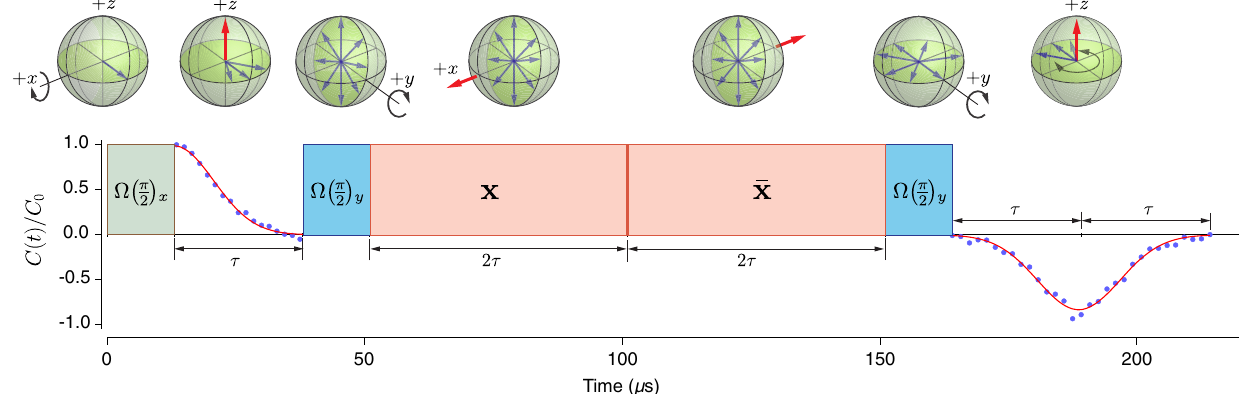
FIG. 3. Pulse diagram and data (blue circles) for the magic-echo pulse sequence performed using τ ¼ 25 μ s and substituting 13- μ s- long OCT-AHT π /2 pulses in place of hard-pulse rotations. The correlation measurements are performed after applying an Ω ð π /2 Þ ¯ x pulse (not shown) at the times corresponding to the data points. The Bloch sphere diagrams above show the spin orientations (blue arrows) during the magic-echo sequence. The red arrows point in the direction of the external magnetic field during free evolution periods and in the direction of the effective field during the rotary